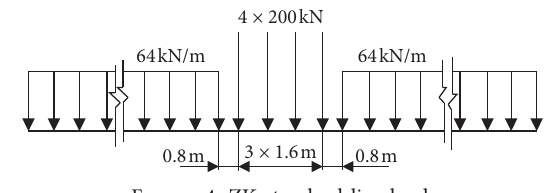
Figure 4: ZK standard live